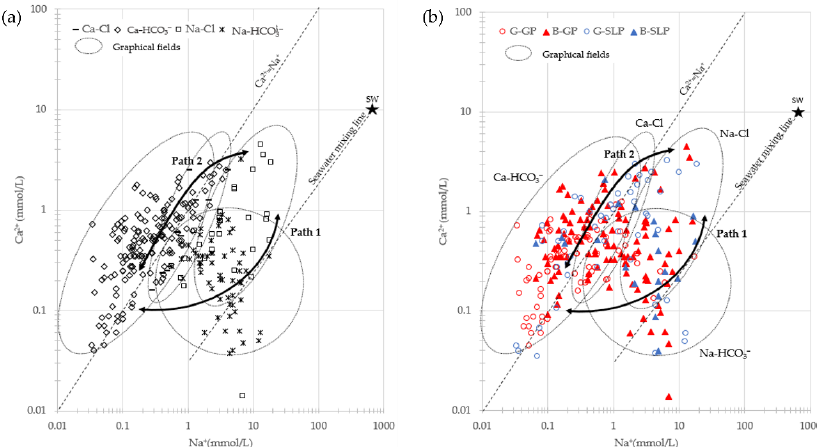
Figure 8. Plots of Na + vs. Ca 2+ concentrations in mmol/l. ( a ) The samples are grouped by ellipses representing the dominant facies (graphical fields); ( b ) the samples are grouped by ellipses representing their respective geological province – aquifer type data sets. The seawater mixing line and seawater concentration (SW) were defined using seawater ratios from Goldberg et al. [45]. GP, Grenville Province; SLP, St. Lawrence Platform; G: granular aquifer; B: bedrock aquifer. The chemical evolution of groundwater can also be interpreted using Gibbs’s diagram (1970) [46]. This diagram of TDS (mg/L) versus the Cl − : Cl − + HCO 3 − (mmol/L) is divided into three poles (rainfall, rock dominance, and seawater) and three hydrogeochemical mechanisms (mineralization, freshening, and mixing). Water – rock interactions and freshening appear to be the main processes affecting the Ca 2+ /Na + cationic exchange within both geological provinces (Figure 9). Water – rock interactions occur mainly for bedrock aquifers, whereas freshening occurs in both aquifers. Freshening occurs when freshwater recharge replaces saline groundwater originating from a seawater intrusion [47].